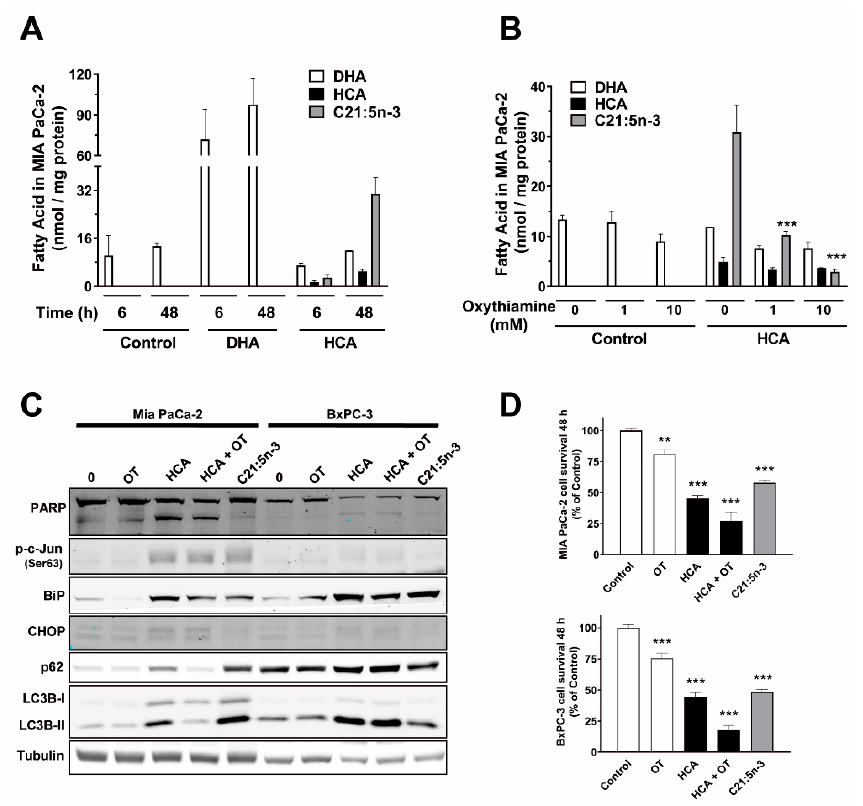
Figure 5. HCA is incorporated into cancer pancreatic cells, and it is metabolized to heneicosapen- taenoic acid (C21:5n-3) through α -oxidation. ( A ) Fatty acid levels (DHA, HCA, C21:5n-3) were quantified by GC after HCA or DHA treatment of MIA PaCa-2 cells (the bars correspond to the mean ± SEM values of 3 independent experiments). ( B ) MIA PaCa-2 cells were pretreated with oxythiamine (OT, 1 or 10 mM) for 1.5 h before exposure to HCA (150 µ M) for 48 h, and the cell’s lipids were extracted and quantified by GC (the bars correspond to the mean ± SEM values of 3 independent experiments). ( C ) Representative immunoblots of the effect of OT and HCA or C21:5n-3 on ER stress/UPR and autophagy markers in MIA PaCa-2 and BxPC-3 cells. ( D ) Effect of oxythiamine (OT, 1 mM), HCA (200 µ M), HCA plus OT (HCA 200 µ M plus OT 1 mM) or C21:5n-3 (200 µ M) on the survival of MIA PaCa-2 and BxPc-3 cells treated for 48 h (the bars correspond to the mean ± SEM values of 3 independent experiments performed in triplicate). Student’s t -test: ** p < 0.01, *** p < 0.001 with respect to the controls. HCA, 2-hydroxycervonic acid; DHA, docosa- hexaenoic acid; C21:5n-3, heneicosapentaenoic acid; OT, oxythiamine; BiP (a.k.a. GRP78), glucose- regulated protein 78; c-Jun, Jun Proto-Oncogene; CHOP (a.k.a. DDIT3), DNA Damage Inducible Transcript 3; LC3B, (a.k.a. ATG8F), Microtubule Associated Protein 1 Light Chain 3 Beta; p62